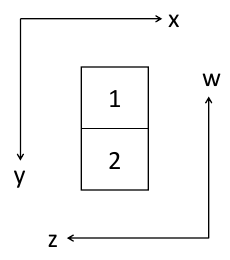
Figure 1 . Giving the orderings of positive variables x i ; y i ; z i ; w i a directional